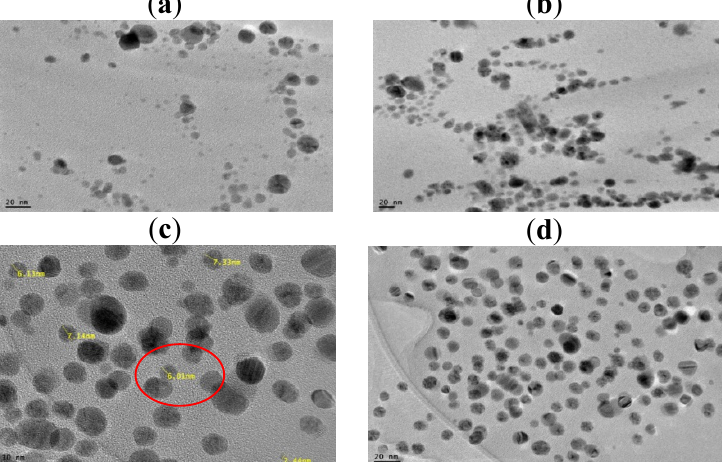
Figure 9. TEM micrographs of Ag NPs prepared with different amounts of